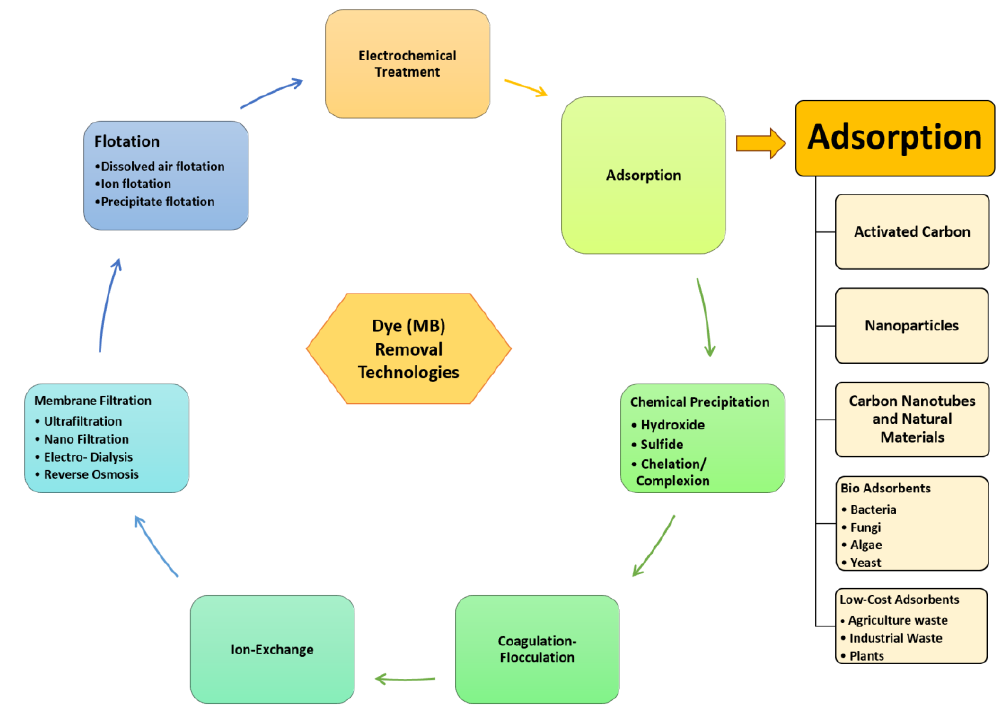
Figure 2. Schematic diagram of tertiary treatment for dye (MB)-removal technologies.